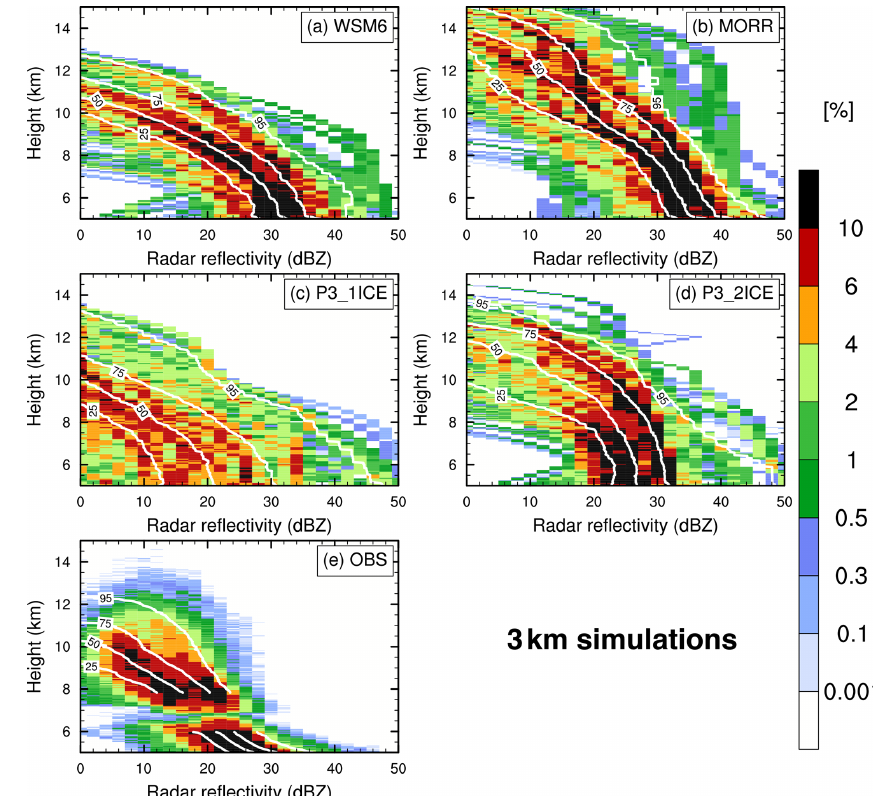
Figure 15. As Fig. 7 but for 3km (d01)